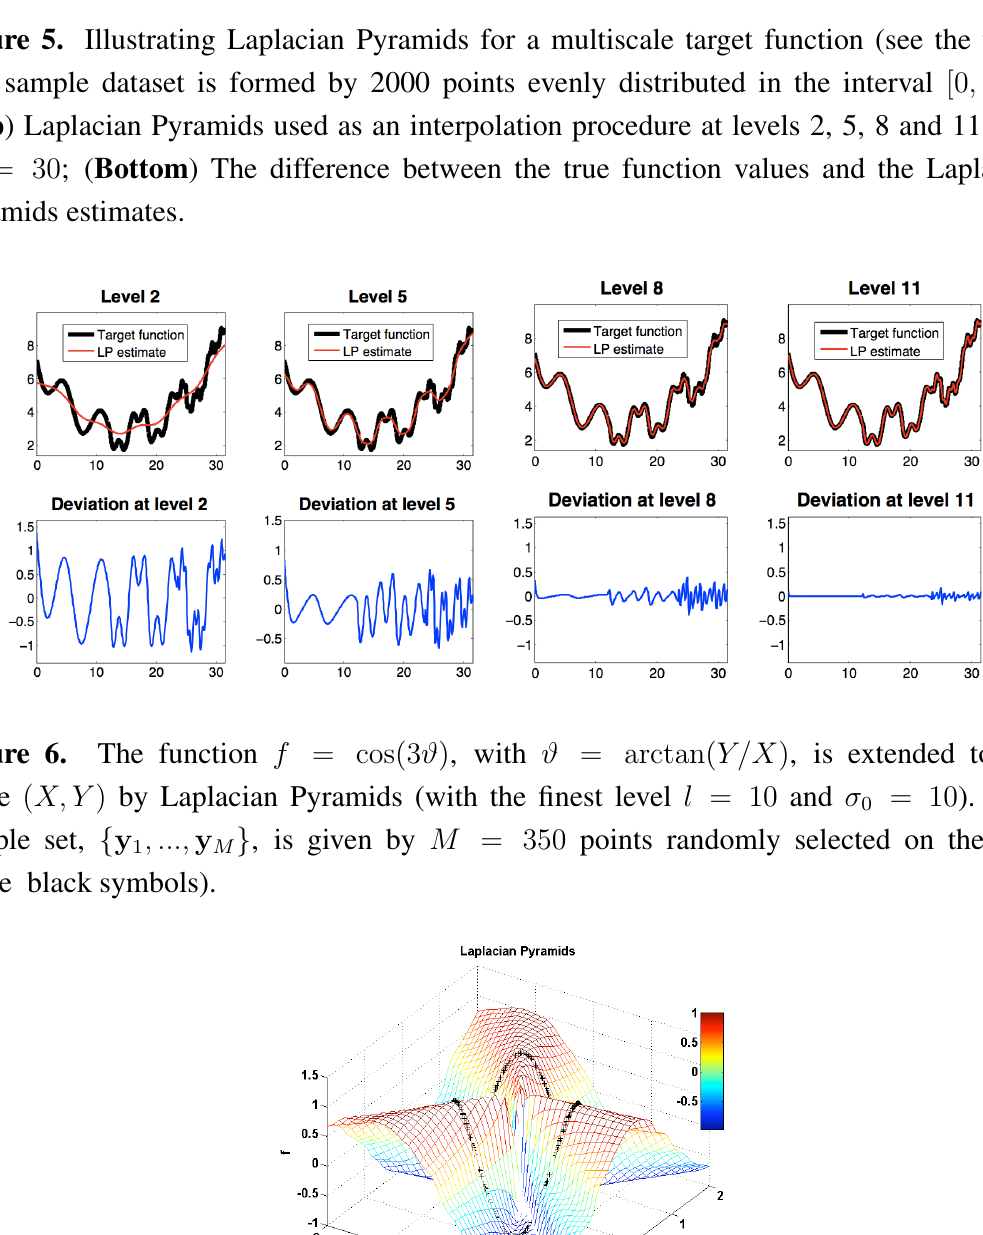
Figure 5. Illustrating Laplacian Pyramids for a multiscale target function (see the text). The sample dataset is formed by 2000 points evenly distributed in the interval [0 , 10 π ] . ( Top ) Laplacian Pyramids used as an interpolation procedure at levels 2, 5, 8 and 11 with σ = 30 ; ( Bottom ) The difference between the true function values and the Laplacian 0 Pyramids estimates.